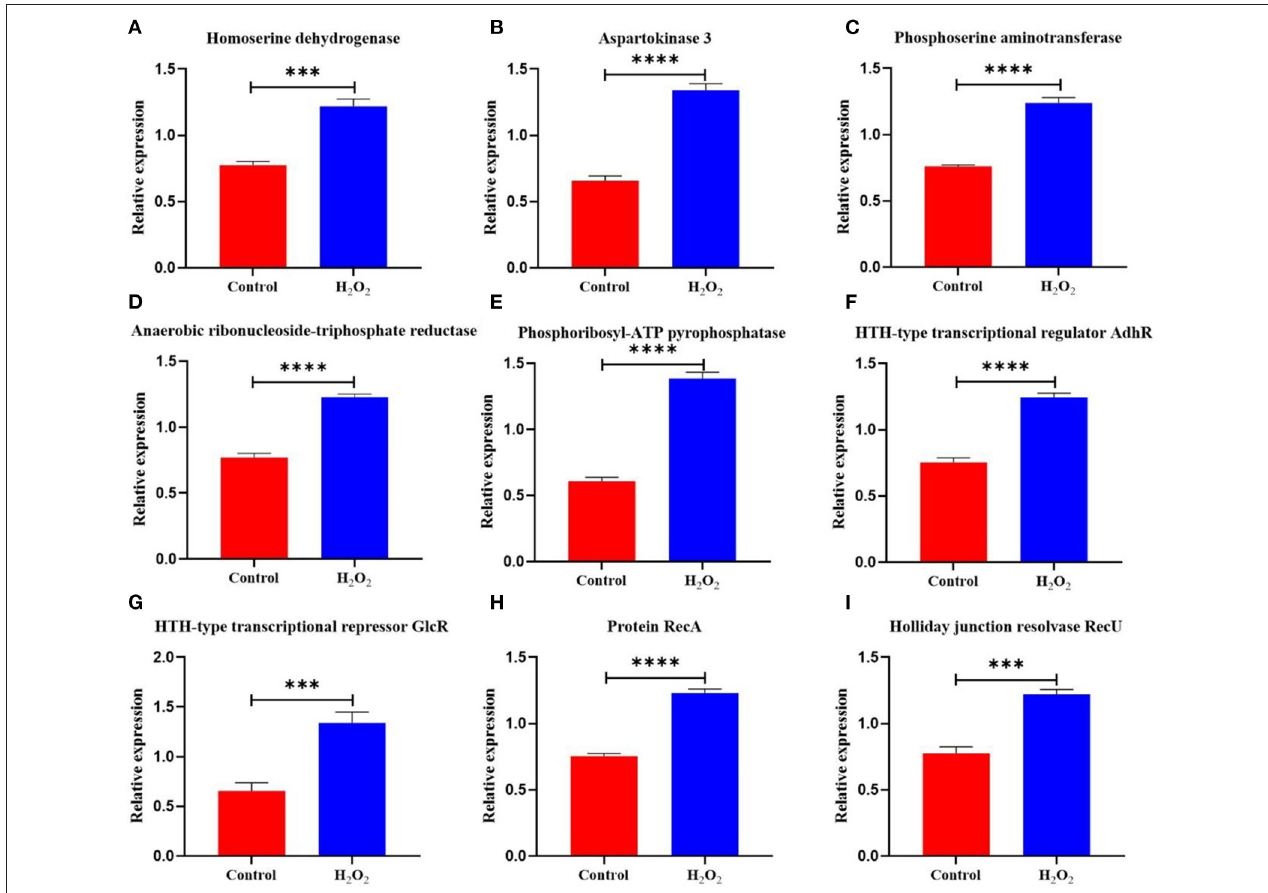
FIGURE 5 | The differentially expressed proteins in the amino acid biosynthesis and DNA repair system of L. plantarum KM1 under H 2 O 2 stress. Red: control group; blue: H 2 O 2 group. *** p < 0.001; **** p < 0.0001. Homoserine dehydrogenase (A) , aspartokinase 3 (B) , phosphoserine aminotransferase (C) , anaerobic ribonucleoside-triphosphate reductase (D) , phosphoribosyl-ATP pyrophosphatase (E) , HTH-type transcriptional regulator AdhR (F) , HTH-type transcriptional regulator GlcR (G) , protein RecA (H) , and holliday junction resolvase RecU (I)